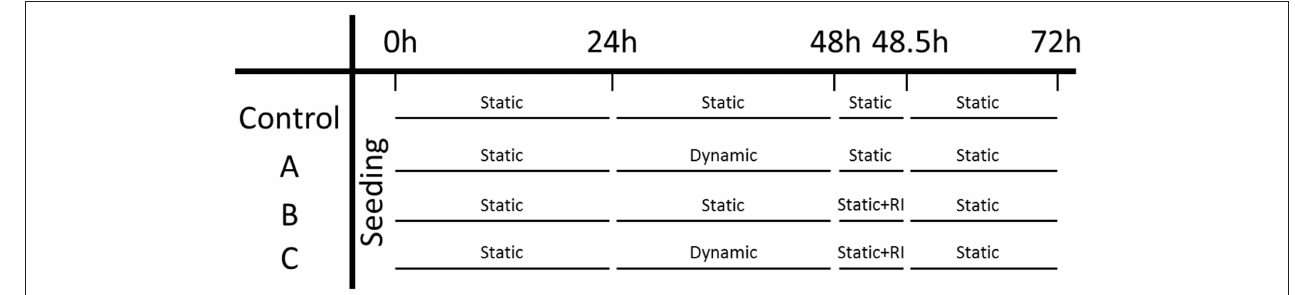
FIGURE 5 | Experiment design: the left column indicates the three experimental groups and the control group. Each time point is indicated on the top row.